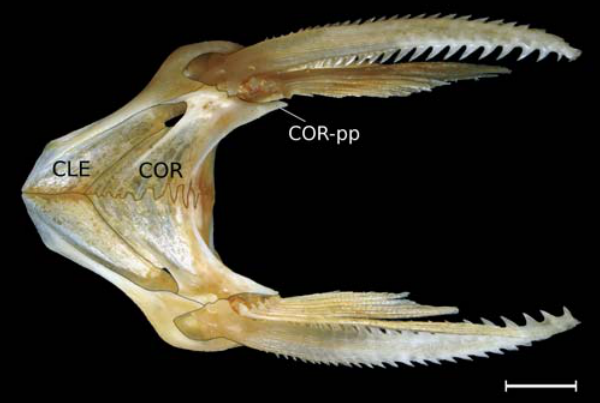
Fig. 11. Pectoral girdle of Leptodoras oyakawai , MZUSP 95722, 73 mm SL, in ventral view. CLE cleithrum, COR cora- coid, COR-pp coracoid posterior process. Scale bar 5 mm.